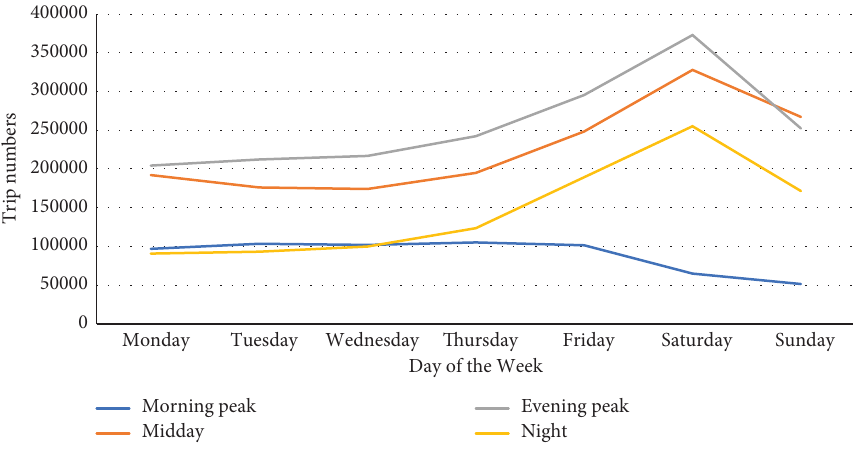
Figure 3: Trip patterns based on the day-of-week and time-of-day for the year